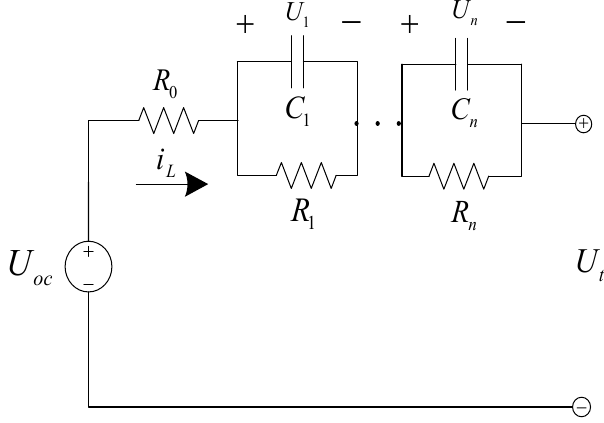
Figure 2. Schematic diagram of the n -order resistance-capacitance (RC) battery